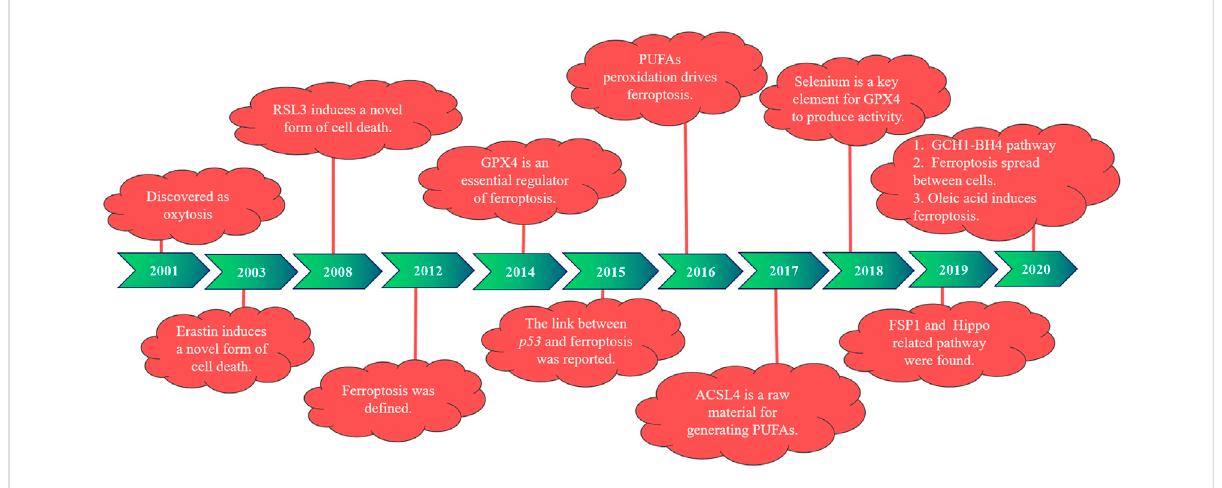
The development of ferroptosis at different time